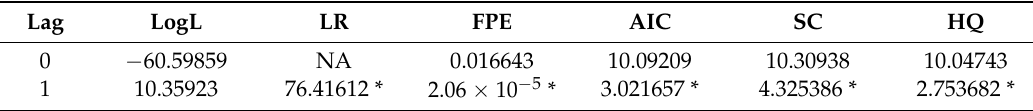
Note: * indicates lag order selected using the criterion. Table 15. Lag selection criteria for ferrous metal ore mining and processing. Lag LogL LR FPE